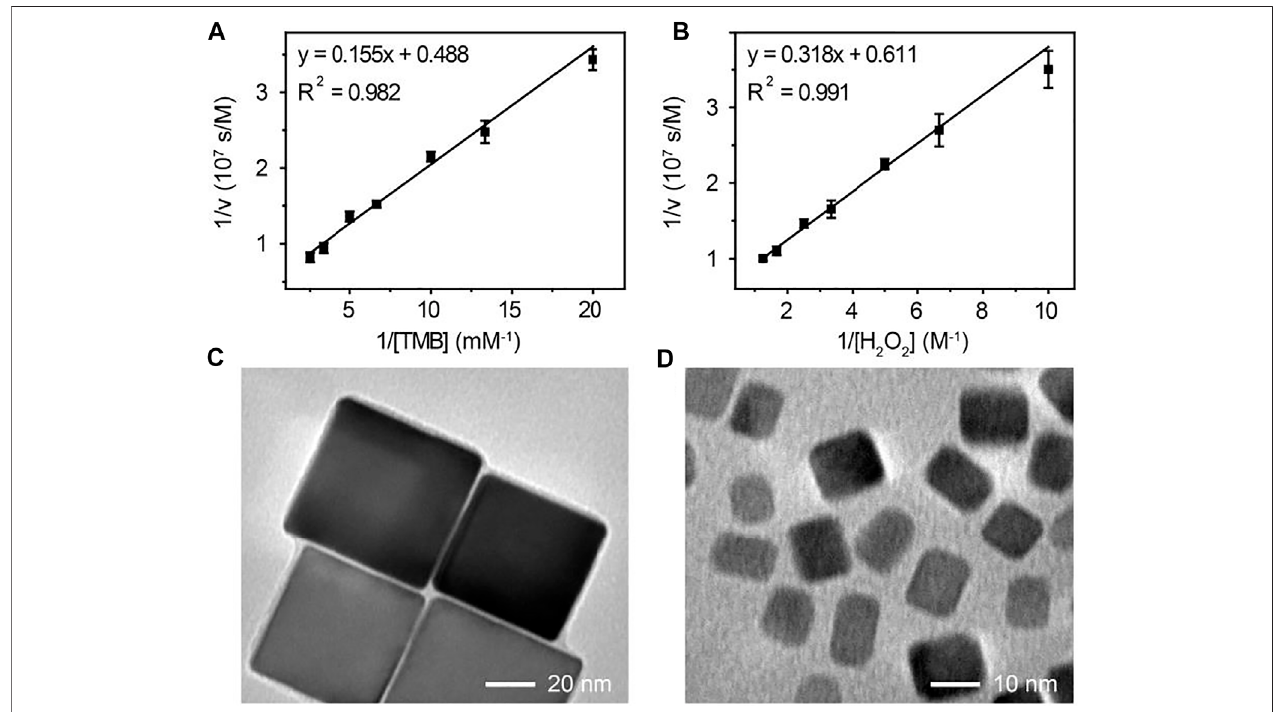
FIGURE3| Thedouble-reciprocalplotofinitialreactionvelocityagainst (A) TMBor (B) H 2 O 2 concentration,thereactioncatalyzedby18 nmPd-Irnanocubes.The TEM images of (C) 51 nm and (D) 7 nm Pd-Ir nanocubes.